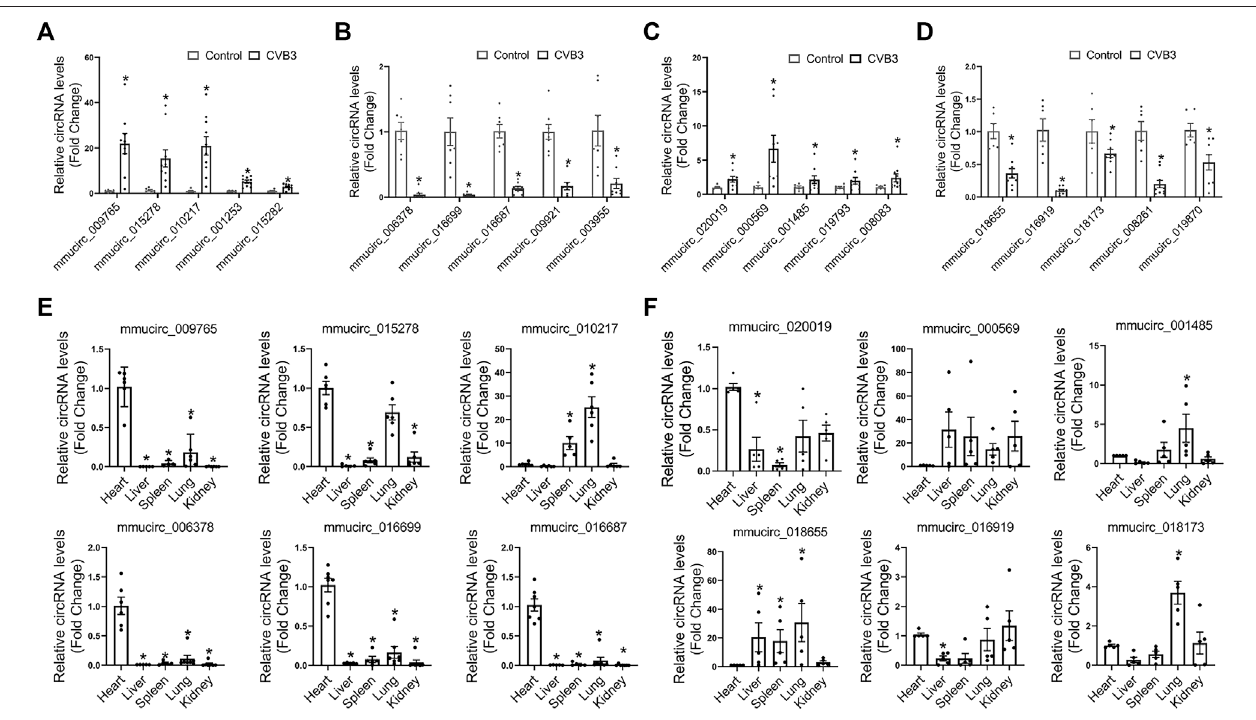
FIGURE 2 | Validation of differentially expressed circRNAs in FM and NFM. (A,B) A/J-speci fi c upregulated (A) and downregulated circRNAs (B) were veri fi ed by qRT-PCR in another heart samples; * p < 0.05 vs. Control. (C,D) C57BL/6-speci fi c upregulated (C) and downregulated (D) circRNAs were veri fi ed by qRT-PCR in another heart samples; * p < 0.05 vs. Control. (E,F) The tissue distribution of A/J-speci fi c (E) and C57BL/6-speci fi c (F) dysregulated circRNAs; * p < 0.05 vs. Heart.